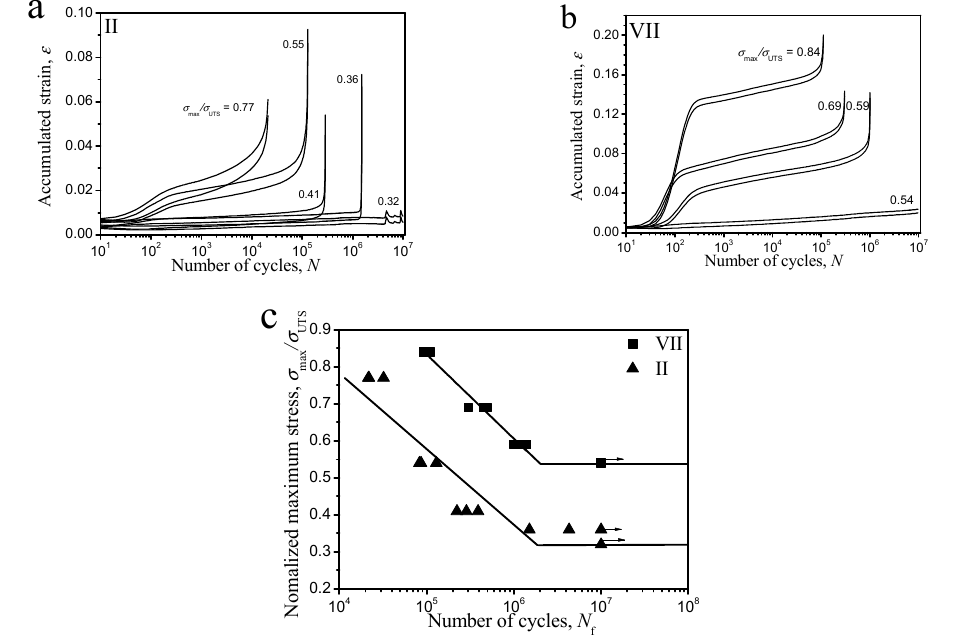
Figure 9. The accumulated strain ε versus number of cycles N of ( a ) sample II, ( b ) sample VII and, ( c ) the measured S-N (Nomalized maximum stress-Number of cycles) curves of samples II and VII under cyclic tension-tension loading.